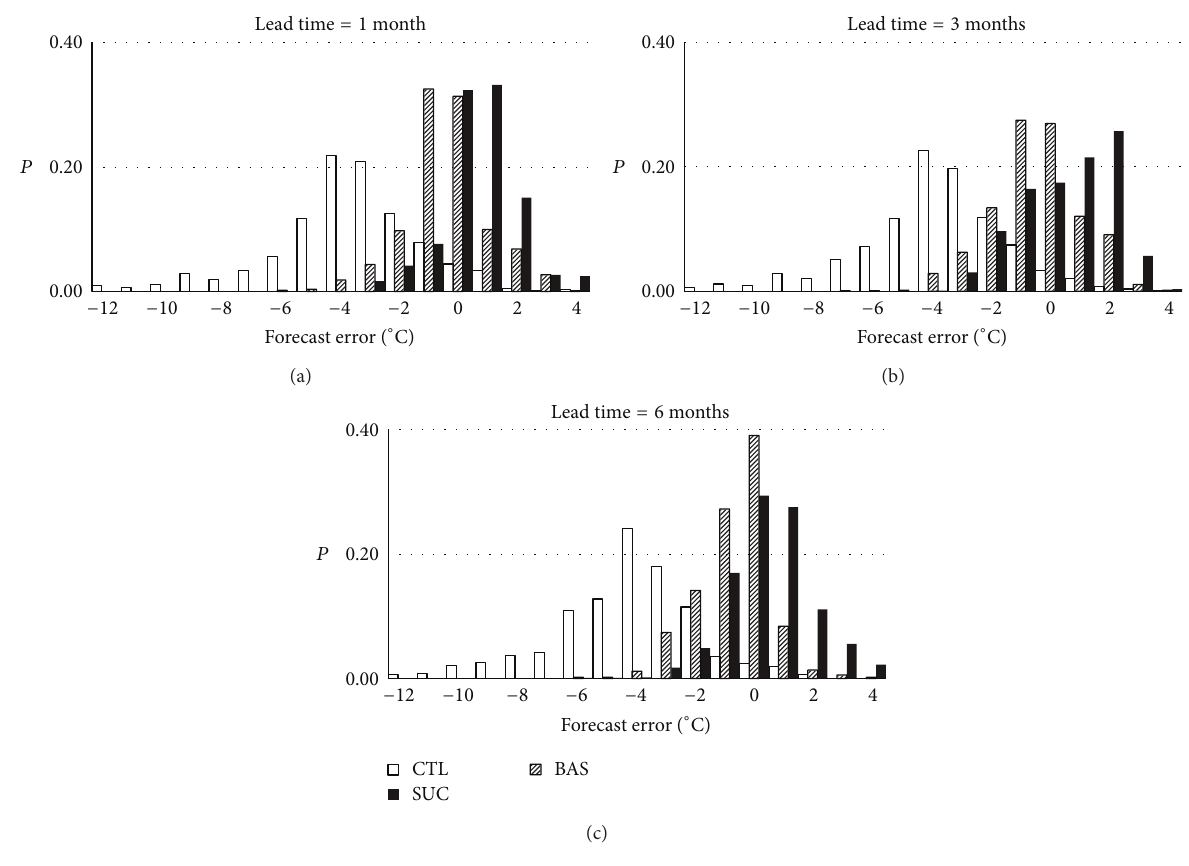
Figure 10: Same as Figure 9 but for Tn ( ∘